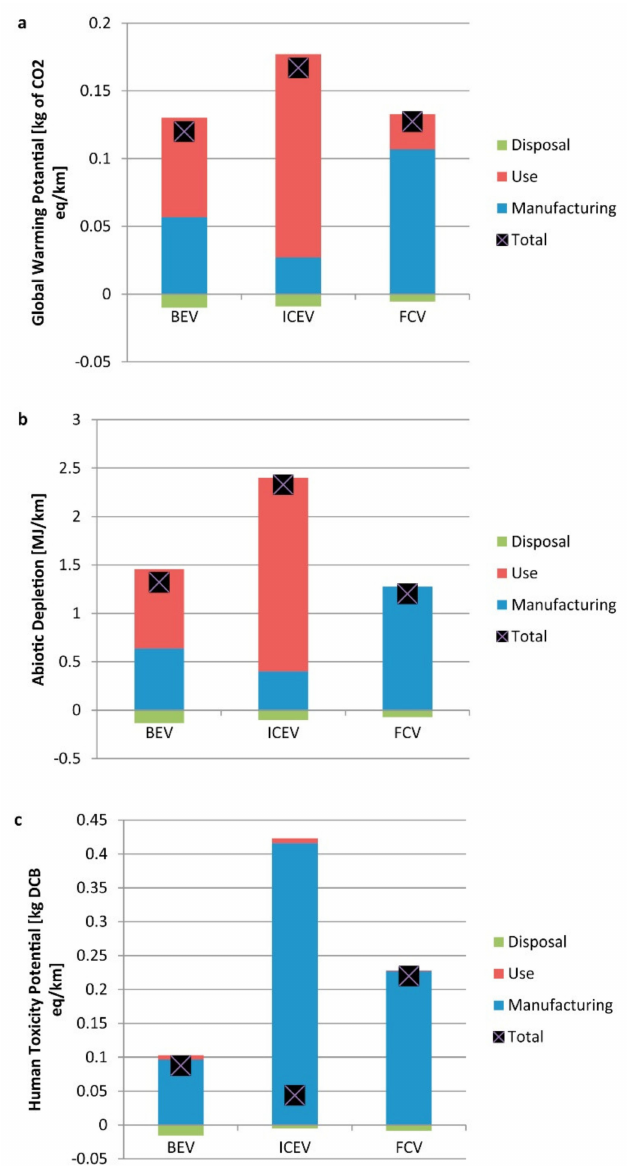
Figure 24. ( a ) Global warming potential, ( b ) abiotic depletion, ( c ) human toxicity potential of fuel cell vehicle (FCV), battery electric vehicle (BEV) and internal combustion engine vehicle (ICEV) for the whole life cycle. Reprinted from [96], © 2020 with permission from